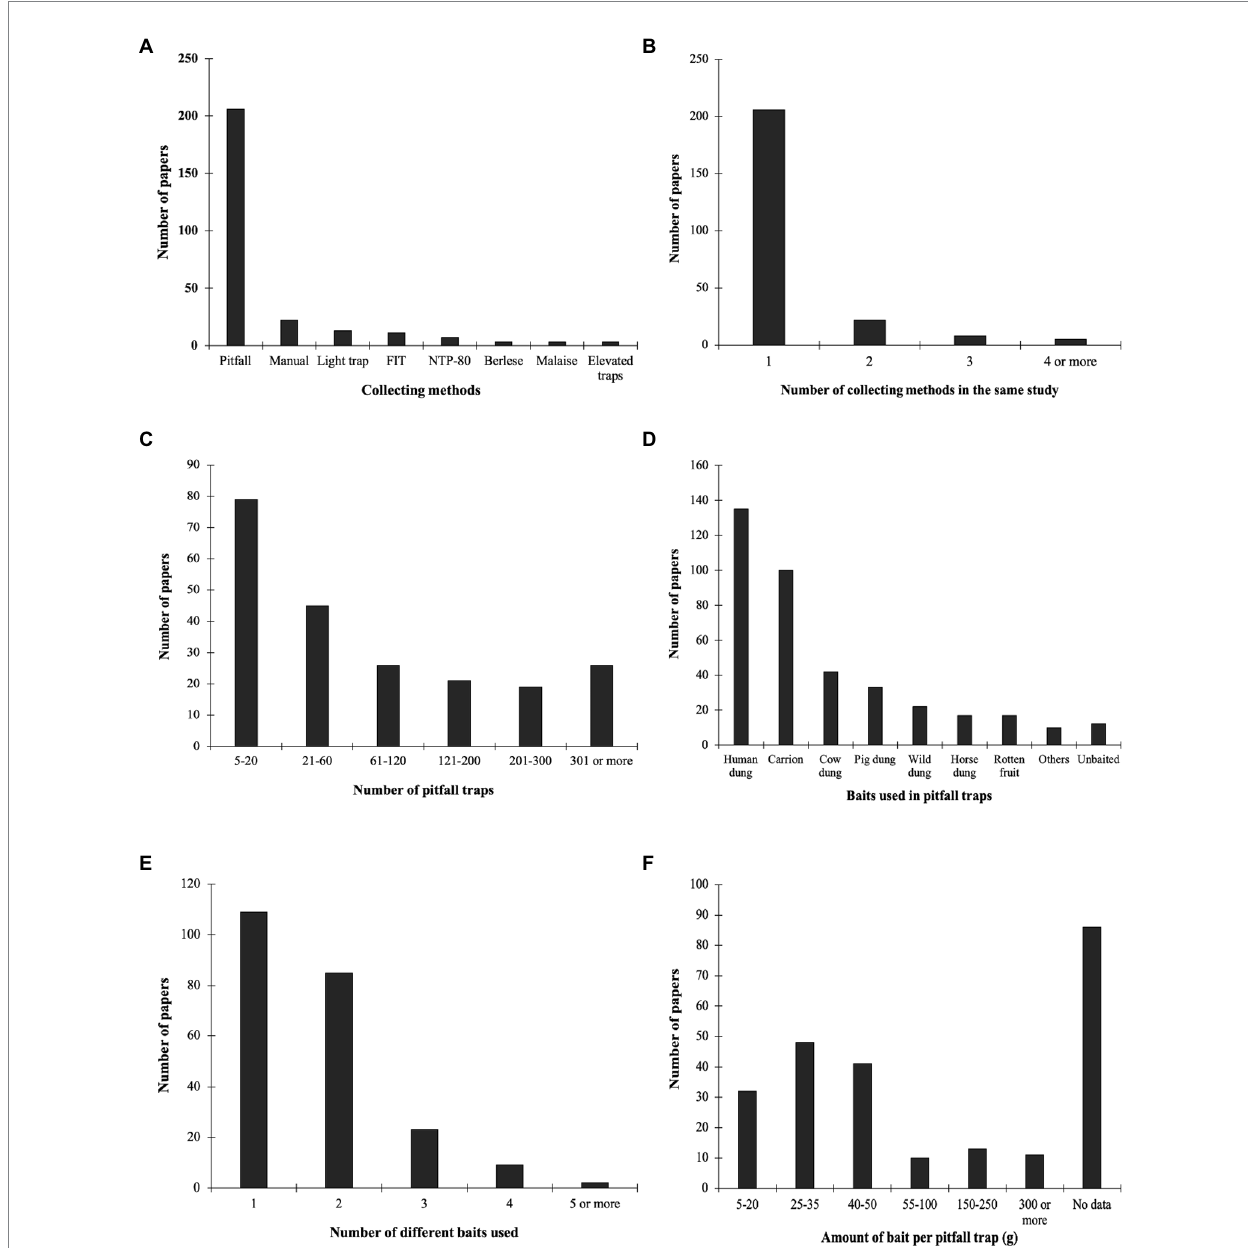
FIGURE 3 Number of published papers on dung beetle sampling compiled in the Neotropics according to different variables: (A) Collecting methods; (B) Number of collecting methods in the same study; (C) Number of pitfall traps; (D) Baits used in pitfall traps; (E) Number of different baits used; and (F) Amount of bait per pitfall